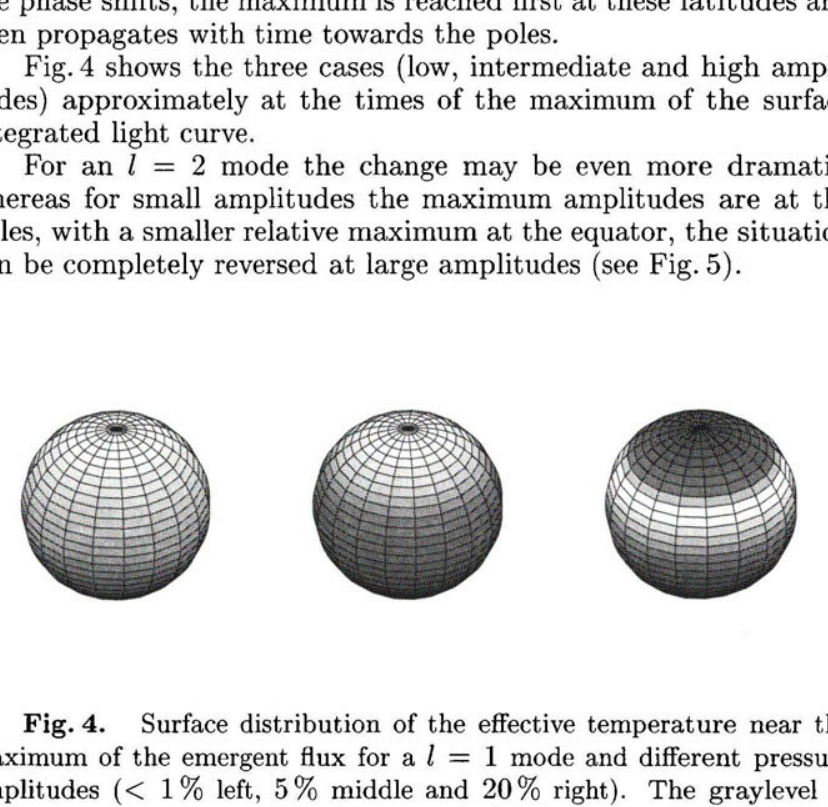
ff (white) and the minimum e